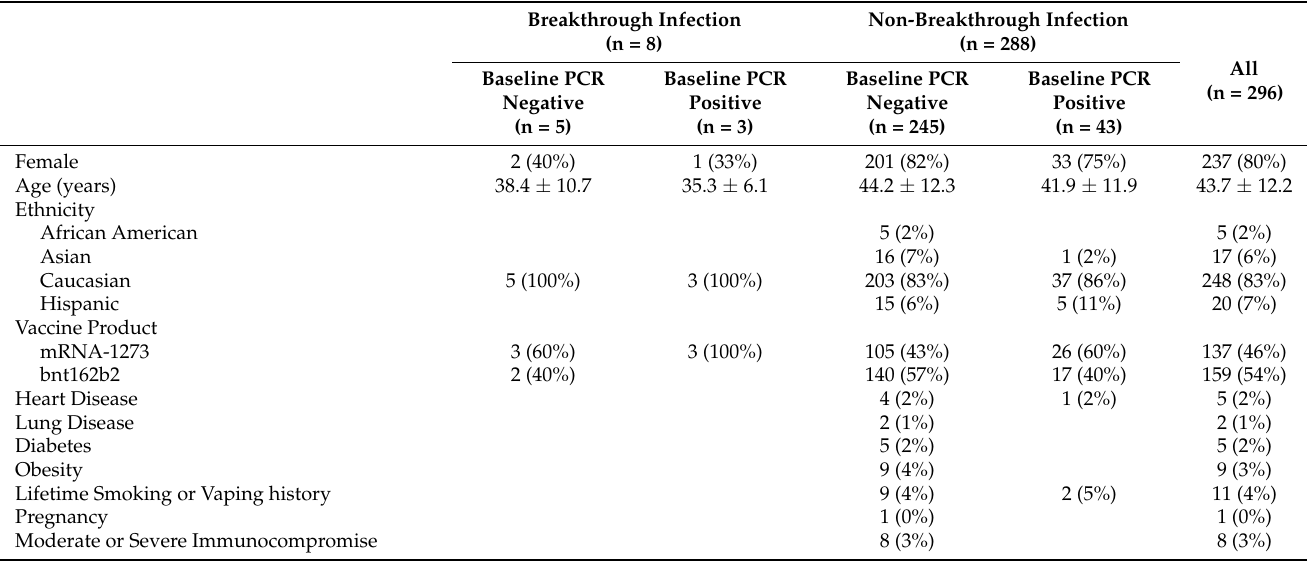
Table 1. Baseline Characteristics of Study